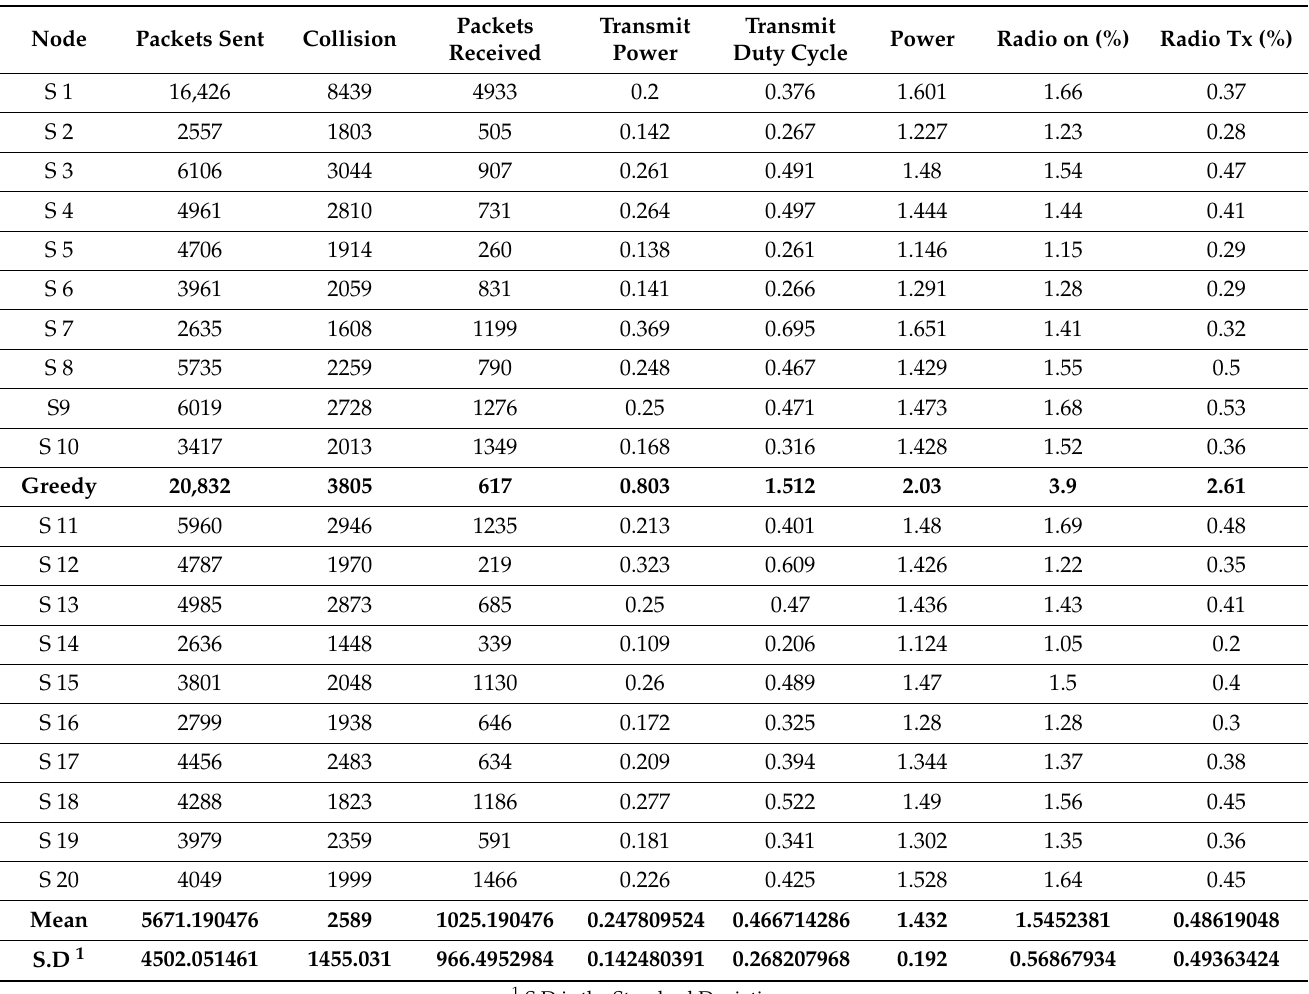
Table 2. The compromised N 4 settings